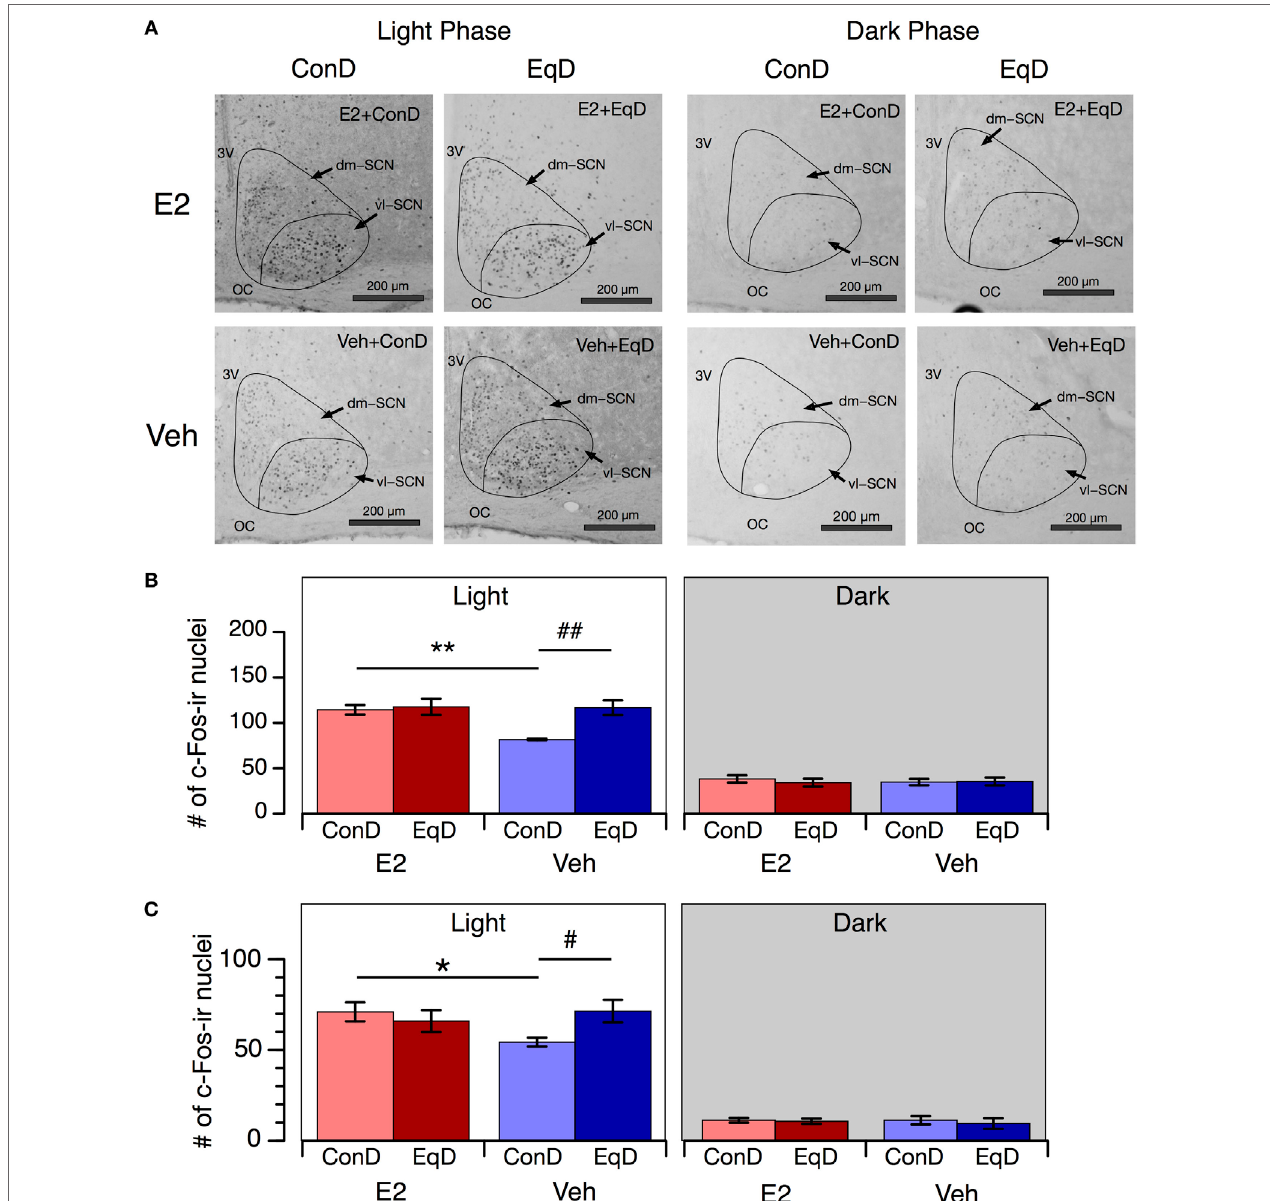
FigUre 4 | The effect of estradiol (E2) replacement and dietary S -equol on c-Fos expression in the suprachiasmatic nucleus (SCN). Rats were ovariectomized and assigned to the E2-replaced or cholesterol [vehicle (Veh)]-treated group. These rats were fed a standard (control) diet (ConD) or an S -equol-containing diet (EqD). Samples were obtained on the 13th day after ovariectomy. (a) Representative light microscopy images of c-Fos-immunoreactive nuclei in the SCN in estradiol- replaced (E2) and vehicle-treated (Veh) rats fed a control (ConD) or an S -equol-containing (EqD) diet during the light [Zeitgeber time (ZT) 2, 0900 h] and dark (ZT14, 2100 h) phases. vl-SCN, ventrolateral SCN; dm-SCN, dorsomedial SCN; OC, optic chiasm; and 3V, third ventricle. Scale bars: 200 µm. (b) The number of c-Fos immunoreactive (c-Fos-ir) nuclei in the whole SCN. (c) The number of c-Fos-ir nuclei in the ventrolateral SCN. Values are shown as the mean ± SEM (ZT2: n = 5 in E2 + ConD and E2 + EqD; n = 6 in Veh + ConD; n = 7 in Veh + EqD; ZT14: n = 5 in each group). * and **, significant differences ( P < 0.05 and P < 0.01, respectively) between the E2-replaced and Veh-treated groups fed the same diet; # and ## , significant differences ( P < 0.05 and P < 0.01, respectively) between the rats fed ConD and EqD with the same